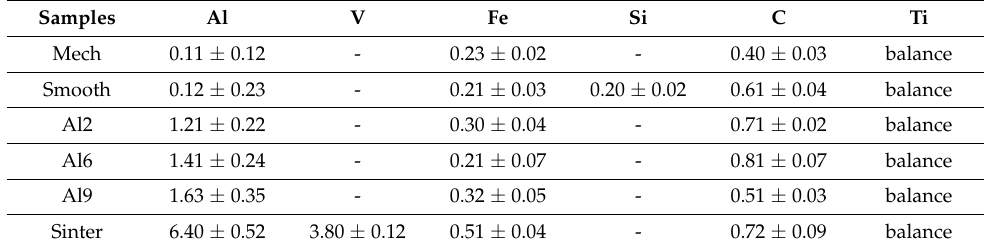
Table 1. Chemical composition of the different surfaces analyzed by the dispersive energy of X-rays. Samples Al V Fe Si